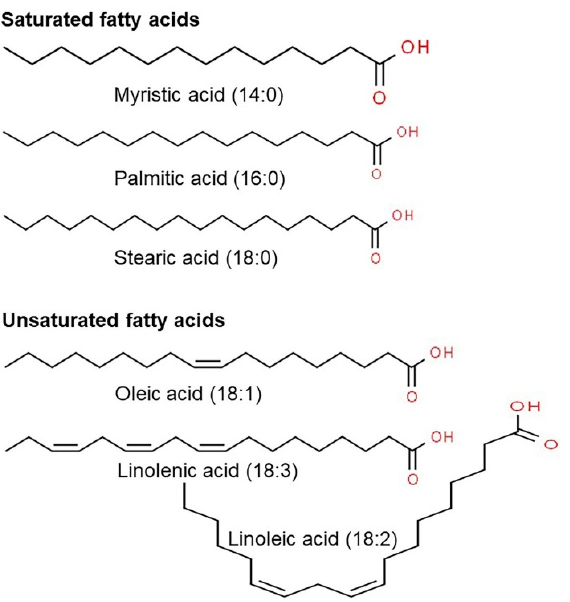
Figure 1. Representative chemical structure of saturated and unsaturated fatty acids present in oats using ChemSpider.